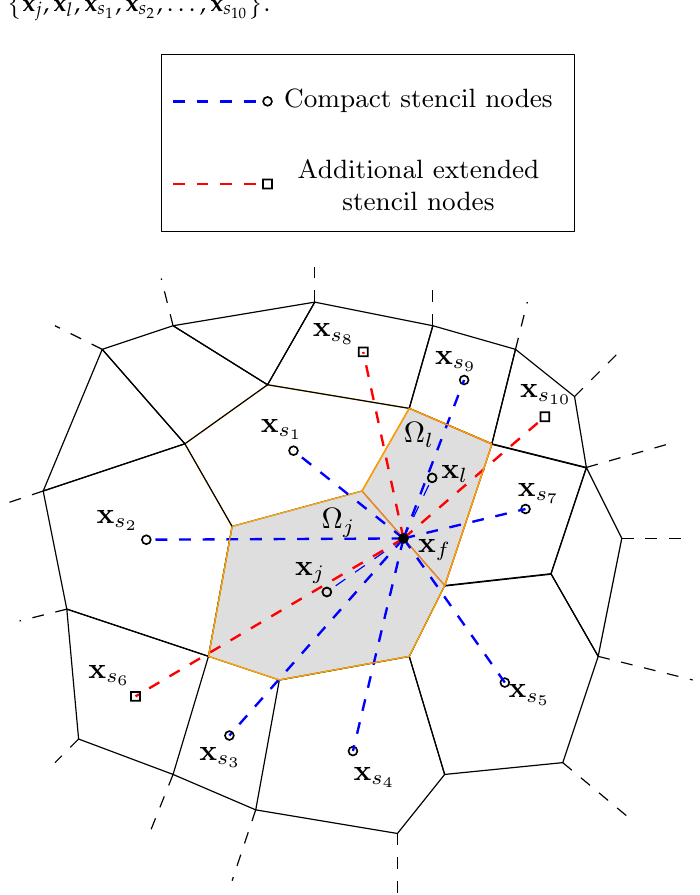
Figure 4. Compact and extended face